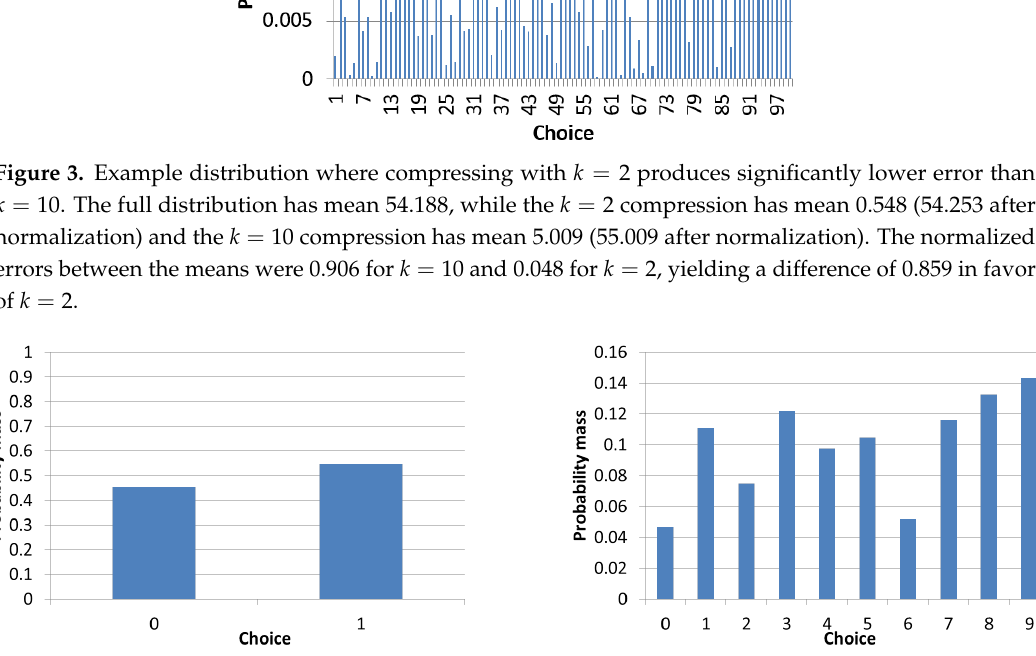
Figure 4. Compressed distribution for k = 2 vs. 10 for example from Figure